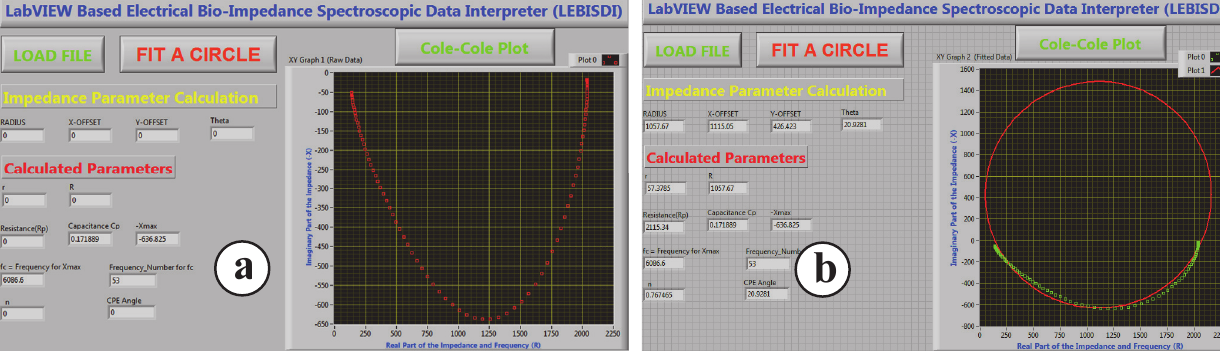
Fig.17: Impedance data fitting and analysis in LEBISDI for a bottle gourd. (a) Before fitting: data loaded. (b) After fitting: data calculated.